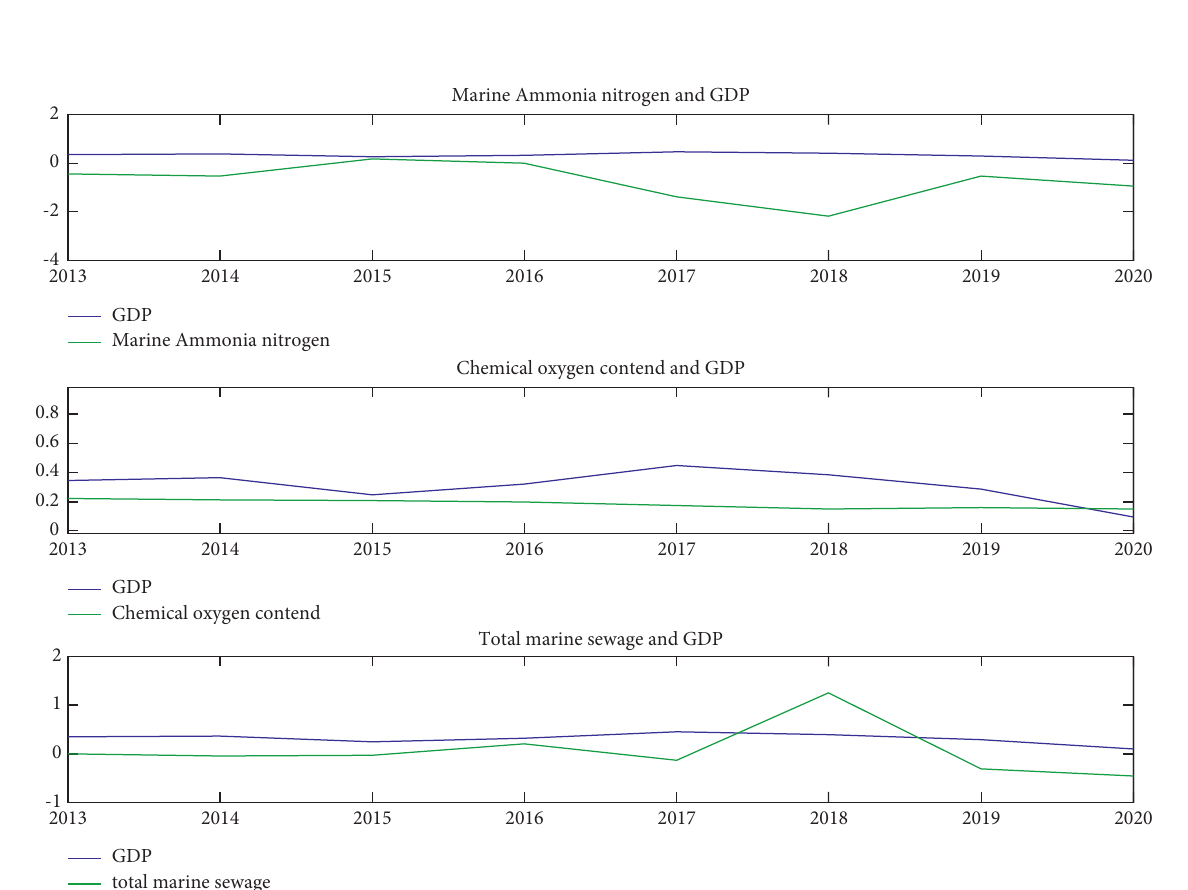
Figure 2: GDP and total sewage, chemical oxygen content, and ammonia